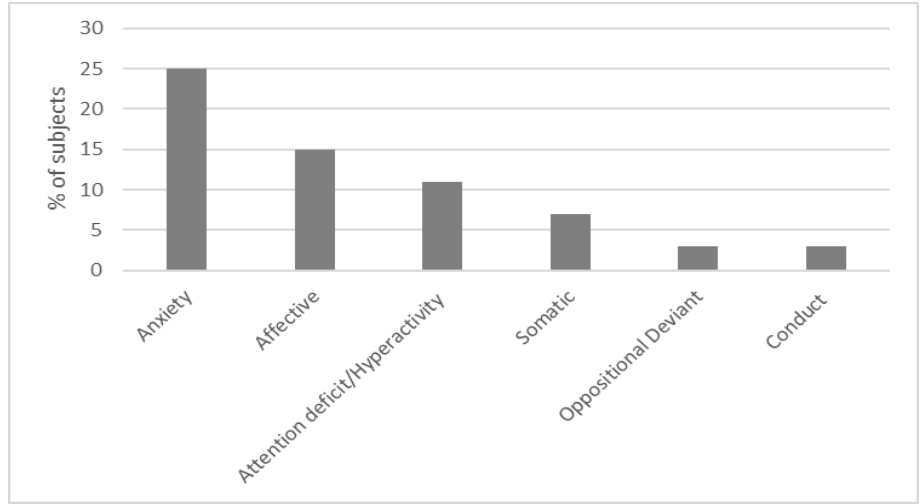
Figure 3. % of scores in the borderline (64 – 69) or clinical (>70) range at the DSM-5 oriented sub-